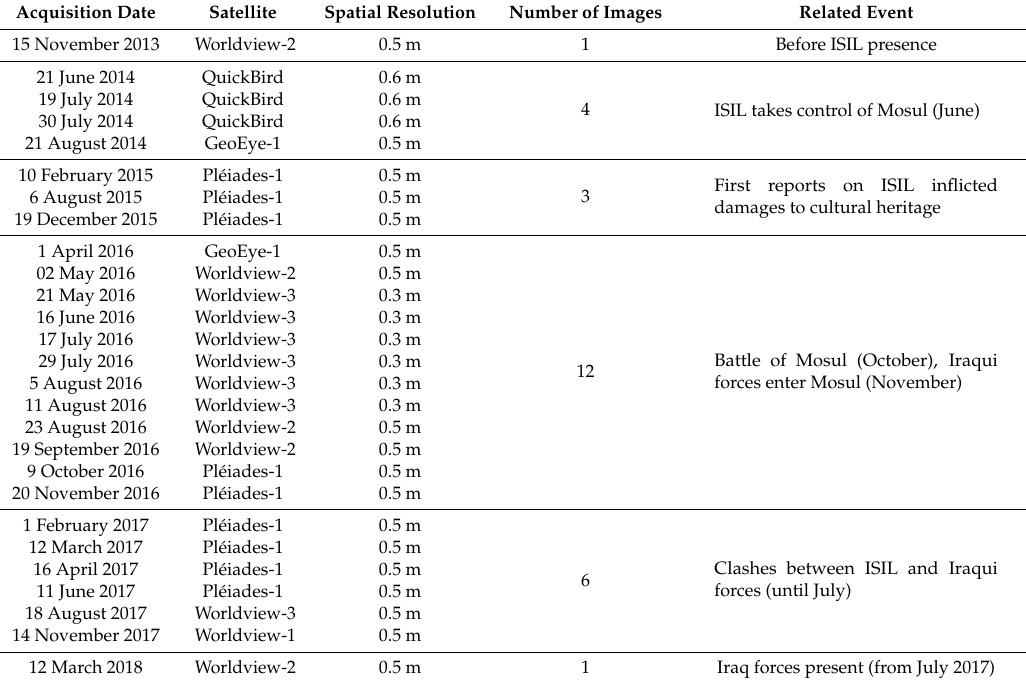
Table 2. Summary of satellite imagery used for the Nineveh and Nebi Yunus archaeological sites, related to Mosul recent event